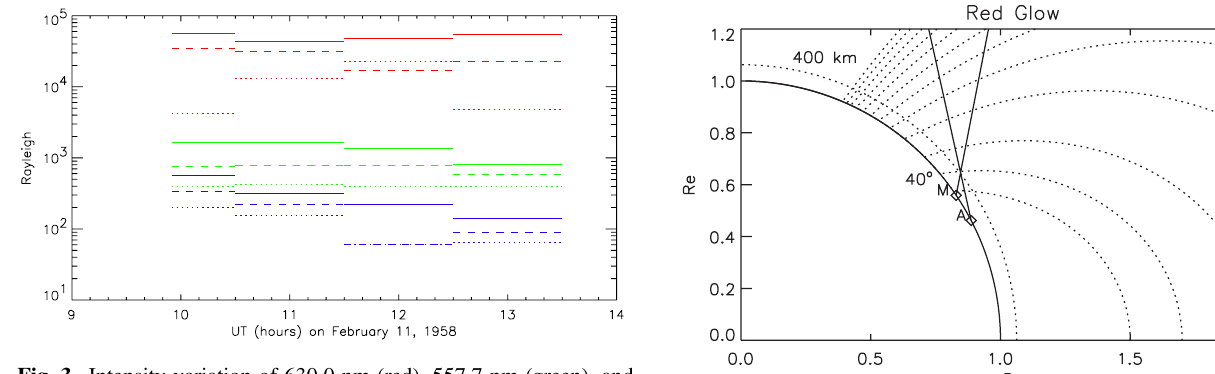
Fig. 3. Intensity variation of 630.0 nm (red), 557.7 nm (green), and 427.8 nm (blue) at different elevation angles of 0 (cid:1) (solid lines), 30 (cid:1) (dashed lines), and 60 (cid:1) (dotted lines). Signi fi cant visible emissions also exist even at the 60 (cid:1) elevation angle.